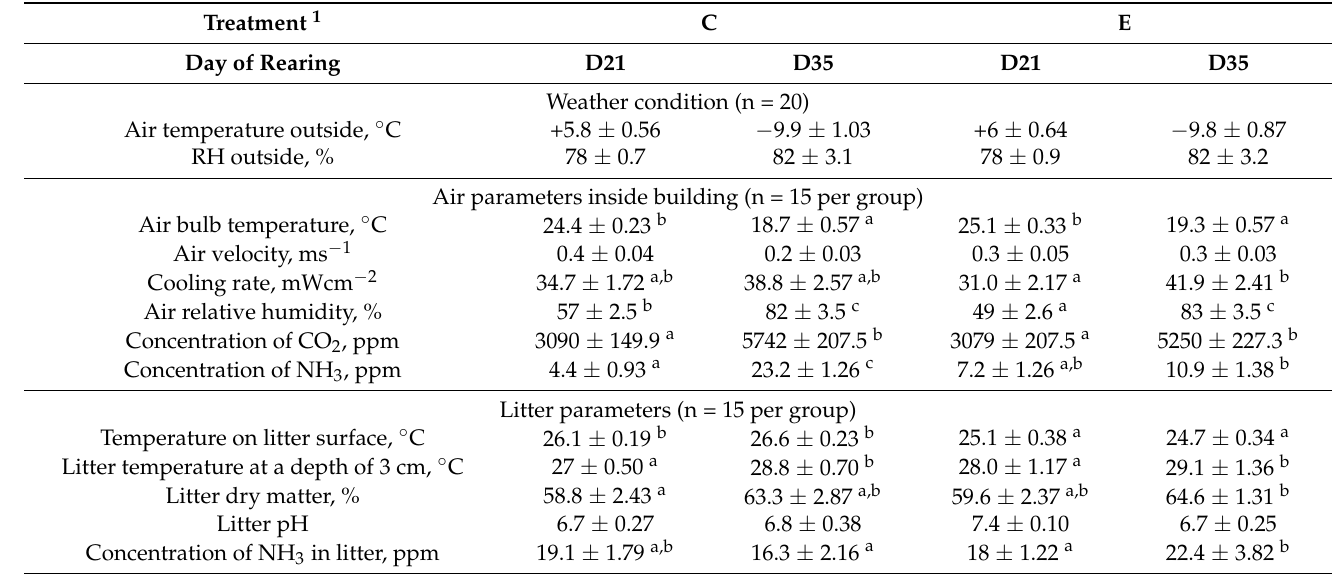
1 C—control group fed complete mixtures without halloysite, E—experimental group fed complete mixtures with 1% of halloysite added; a,b,c Values in the rows marked with various letters differ significantly ( p <